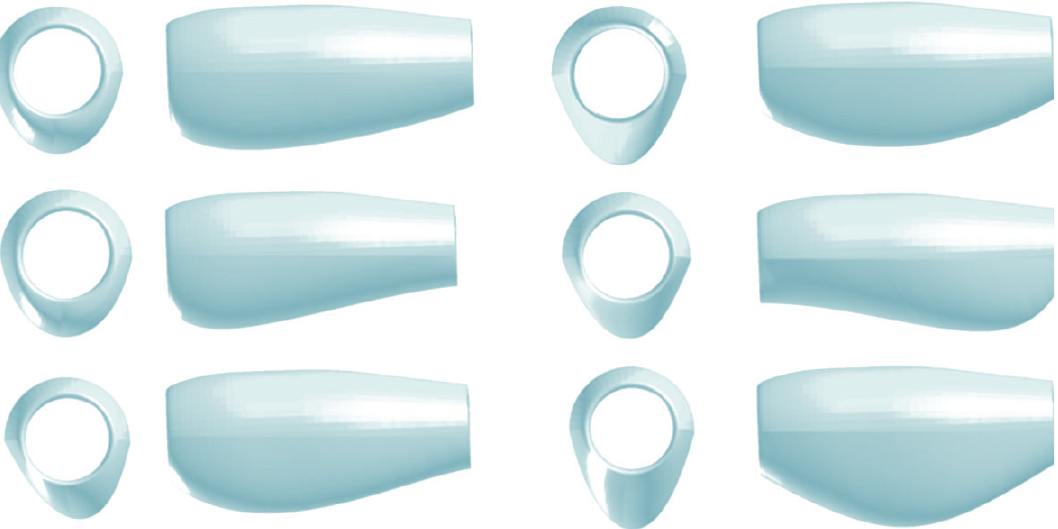
Figure 6: Examples of nacelle shape.